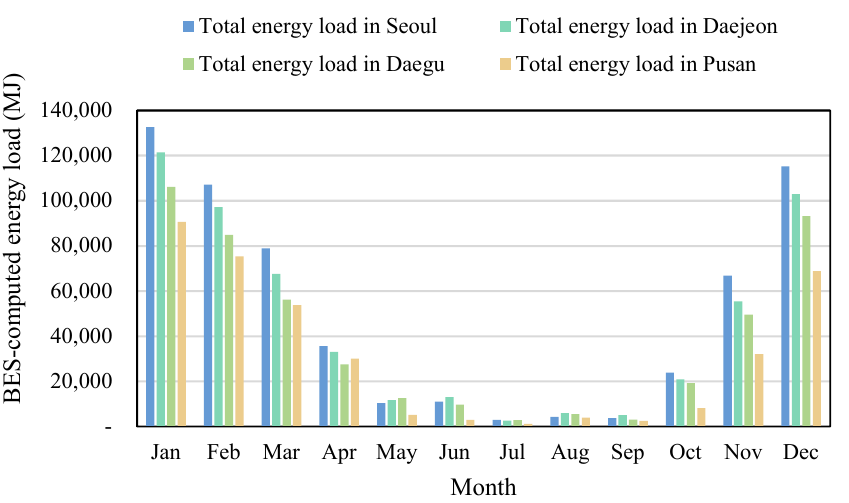
Figure 18. Analysis of monthly energy load after installations of BiRTGs in representative regions of Korea (Seoul, Daejeon, Daegu, and Pusan).